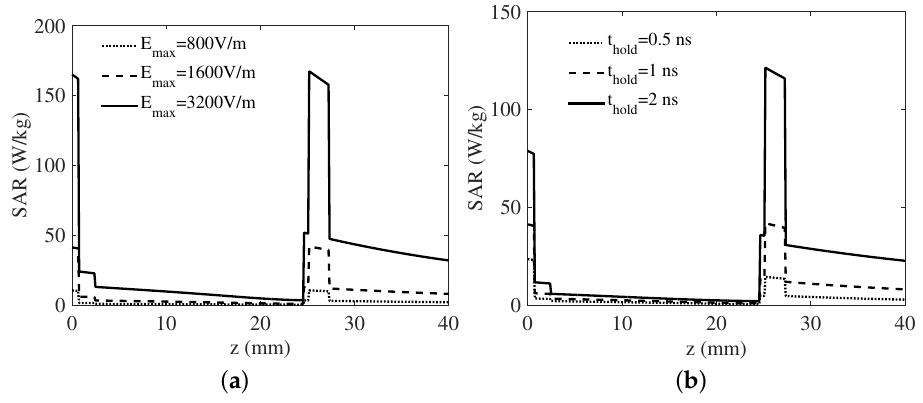
Figure 6. SAR profile obtained by considering a PEF source with ( a ) three different pulse amplitudes; ( b ) three different hold times.